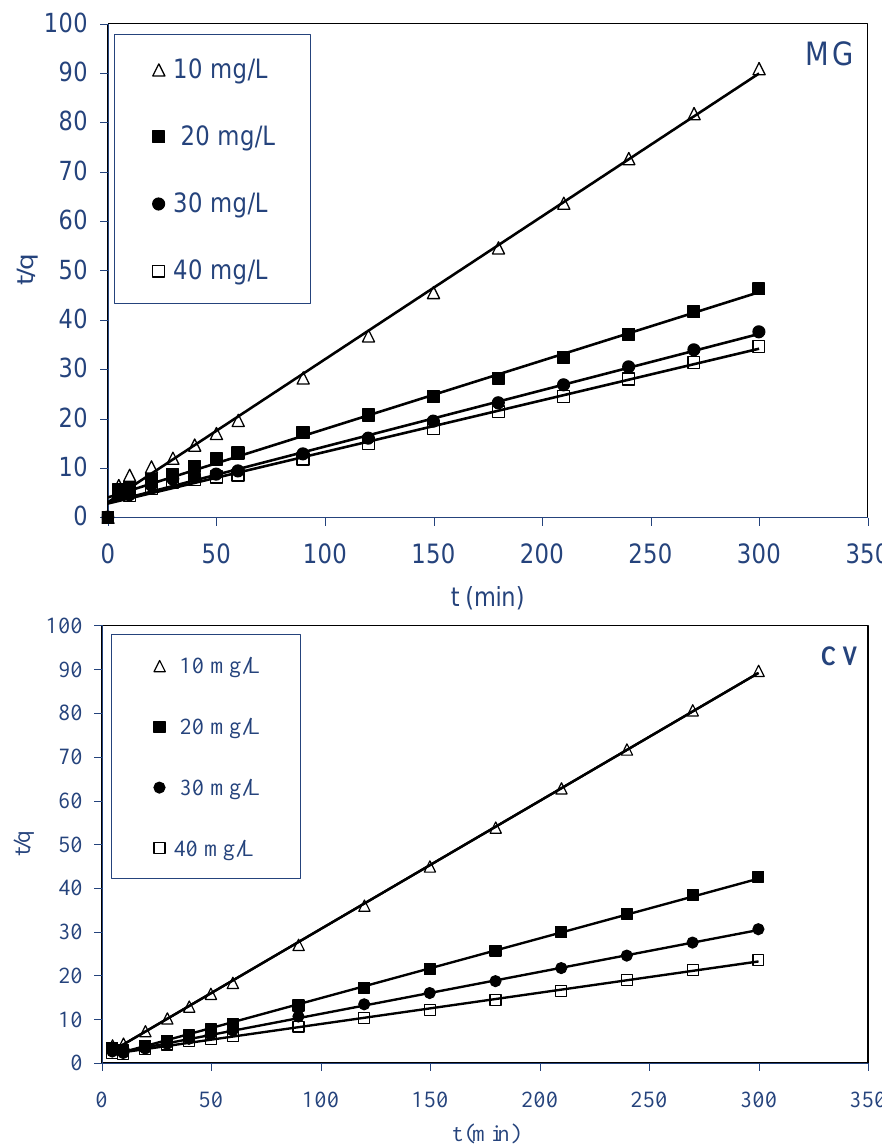
Figure 8. Pseudo-second-order kinetics for the biosorption of both dyes on ALP.